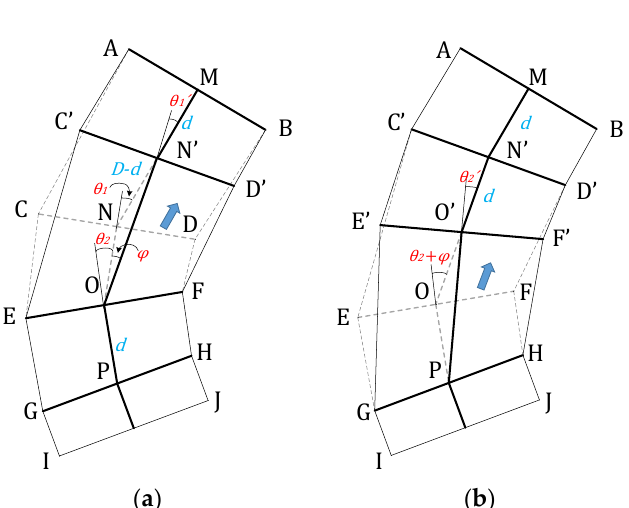
Figure 10. ( a ) A simplified geometric model of the robot at the end of Phase 2, where ON is the cylinder of Segment 2; ( b ) A simplified geometric model of the robot at the end of Phase 3, where PO is the cylinder of Segment